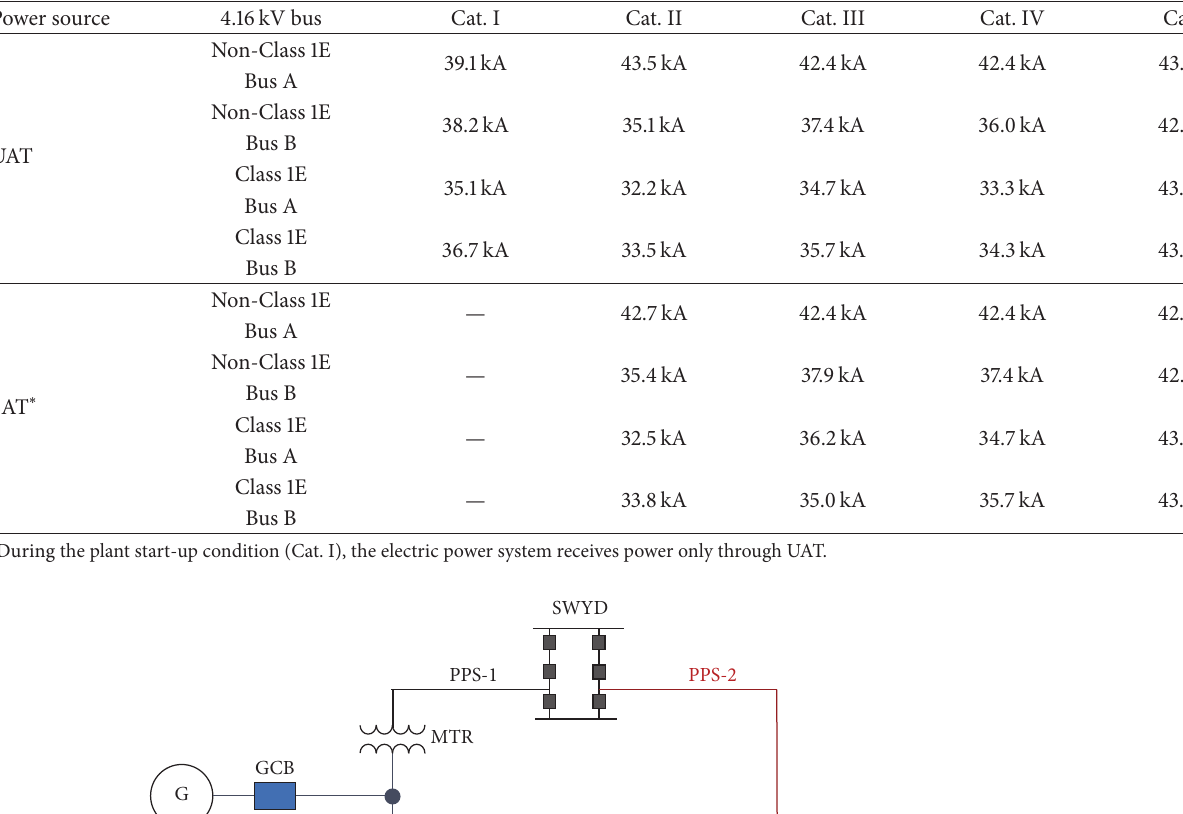
Table 2: The result of short circuit current analysis for APR1400.